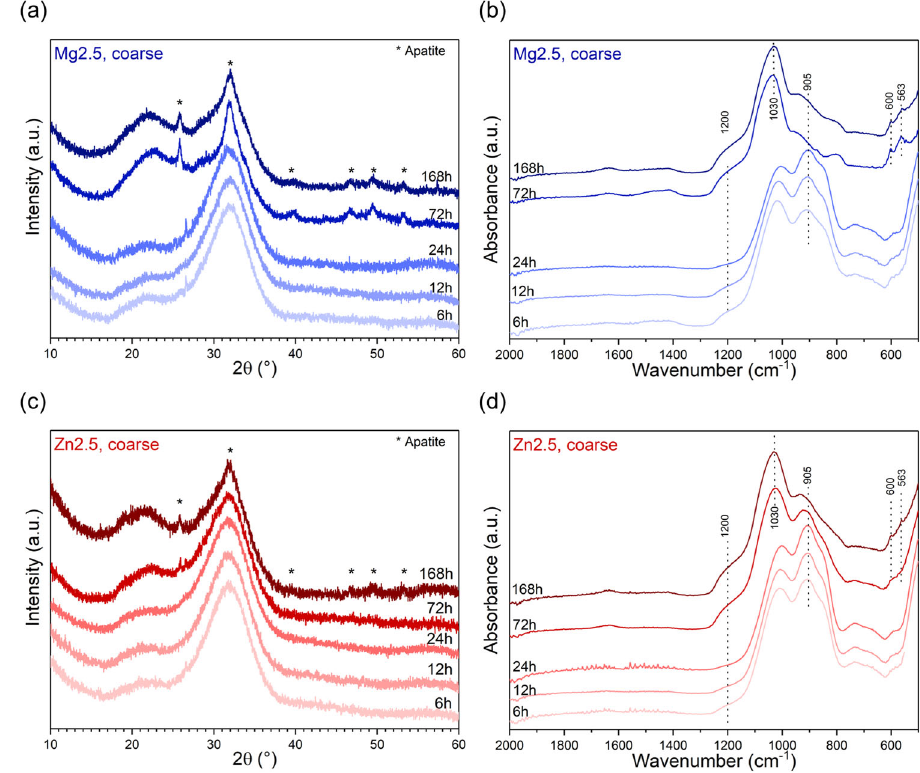
Fig. 4 a , c XRD patterns and b , d ATR-FTIR spectra of coarse particles of glasses ( a , b )